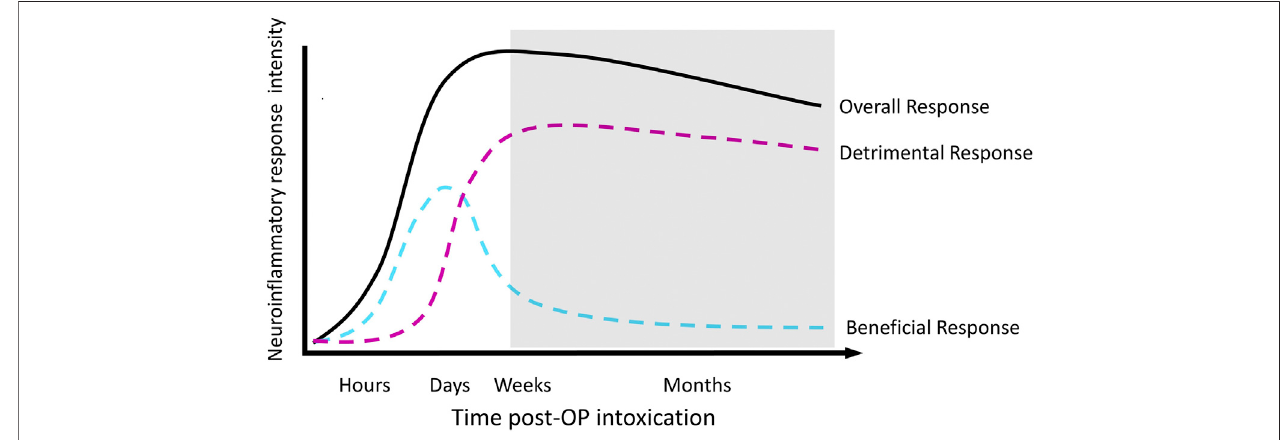
FIGURE 2 | Proposed temporal pro fi le of the neuroin fl ammatory response to acute OP intoxication. The shaded area depicts the development of chronic neurological sequelae.